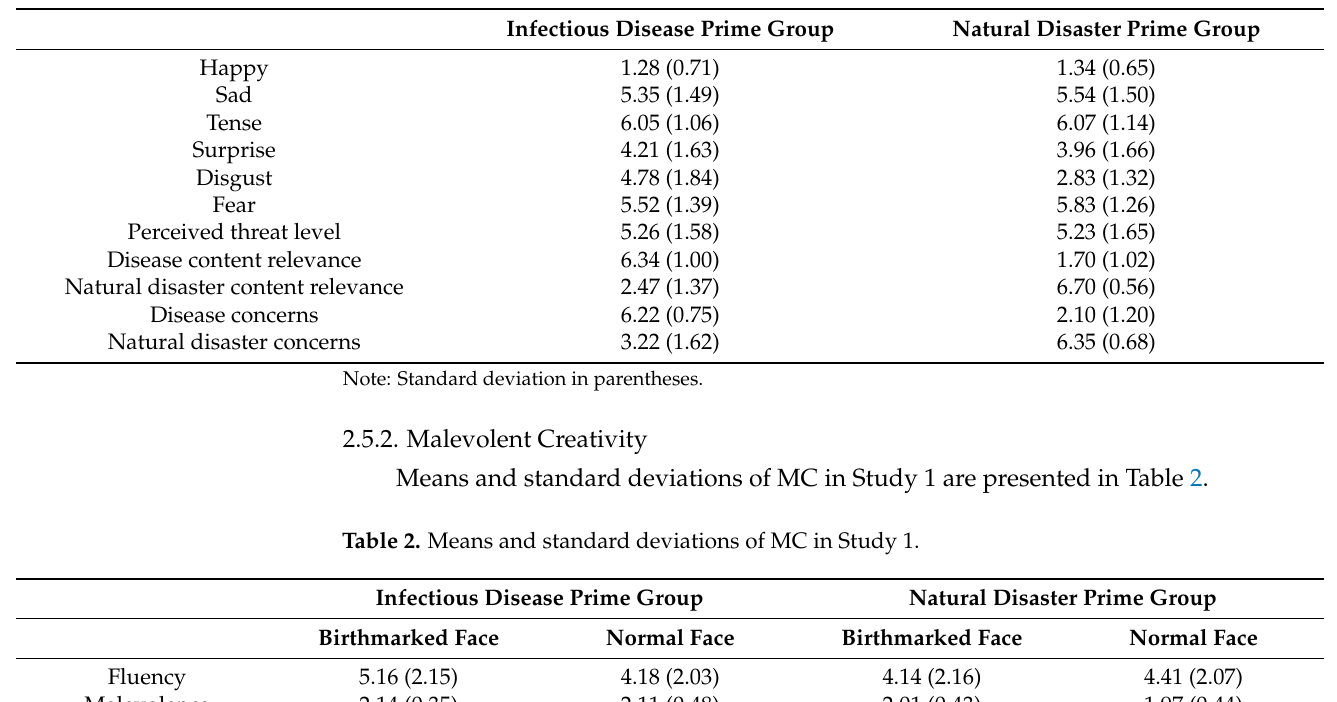
Table 1. Means and standard deviations of manipulation checks.